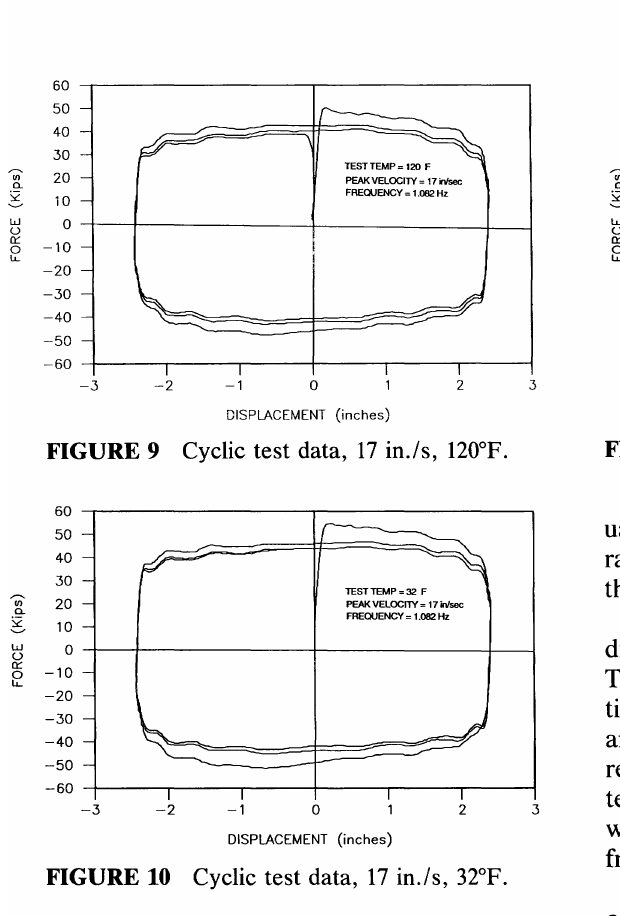
FIGURE 9 Cyclic test data, 17 in./s, 120 o P. FIGURE 10 Cyclic test data, 17 in.ls, 32°P.